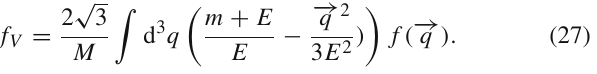
The computed decay constants and leptonic decay widths in the case of charmonium and bottomonium sates are pre- sented in Tables 8 and 9, respectively. The ratio of bottomonium and charmonium states are listed in Table 10. Along with the mass predictions, the leptonic decay widths are also important for the identification of the structures of quarkonia-like states.